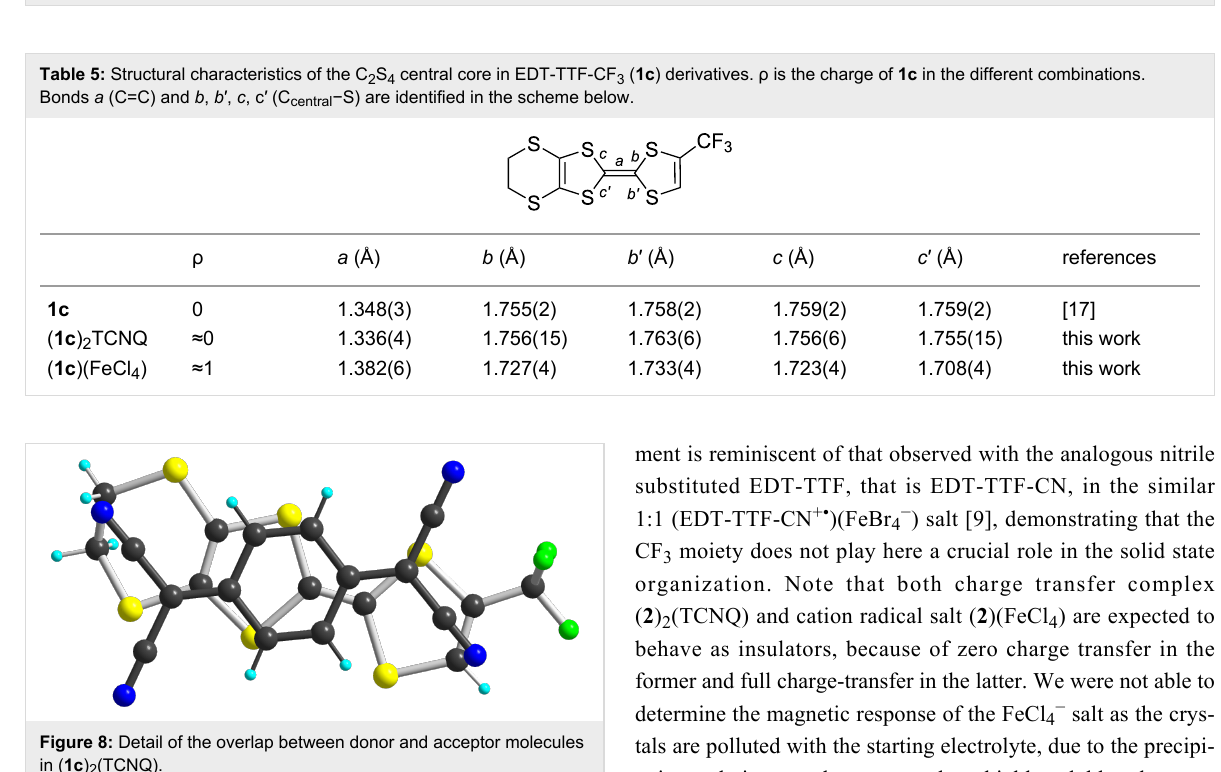
affects the central C 2 S 4 core of the donor (Table 4) with a lengthening of the C=C central double bond a , and an asso- ciated shortening of the C central − S bonds b , b ′ , c , c ′ ). Note that this effect is stronger on the ( c , c ′ ) C central –S bonds of the most electron-rich dithiole ring bearing the dithioethylene